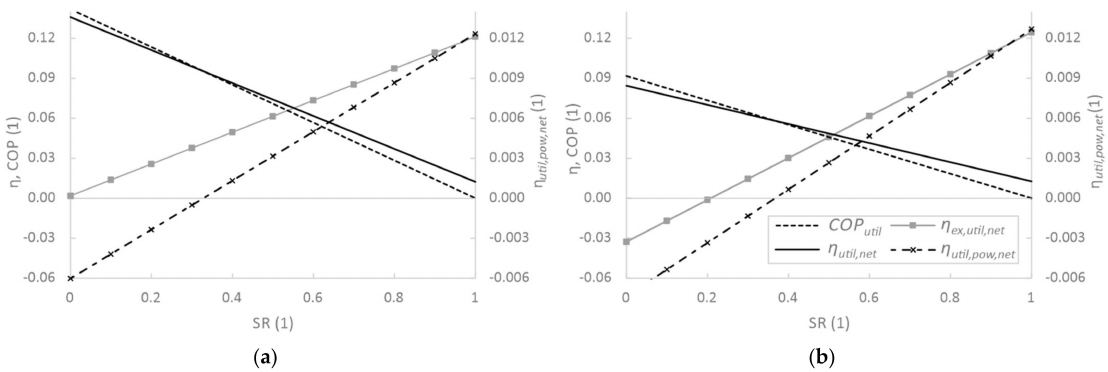
Figure 7. Energy and exergy efficiency and COP for heat source utilisation with respect to the splitting ratio, for APCC ( a ) and ORC–VCC ( b